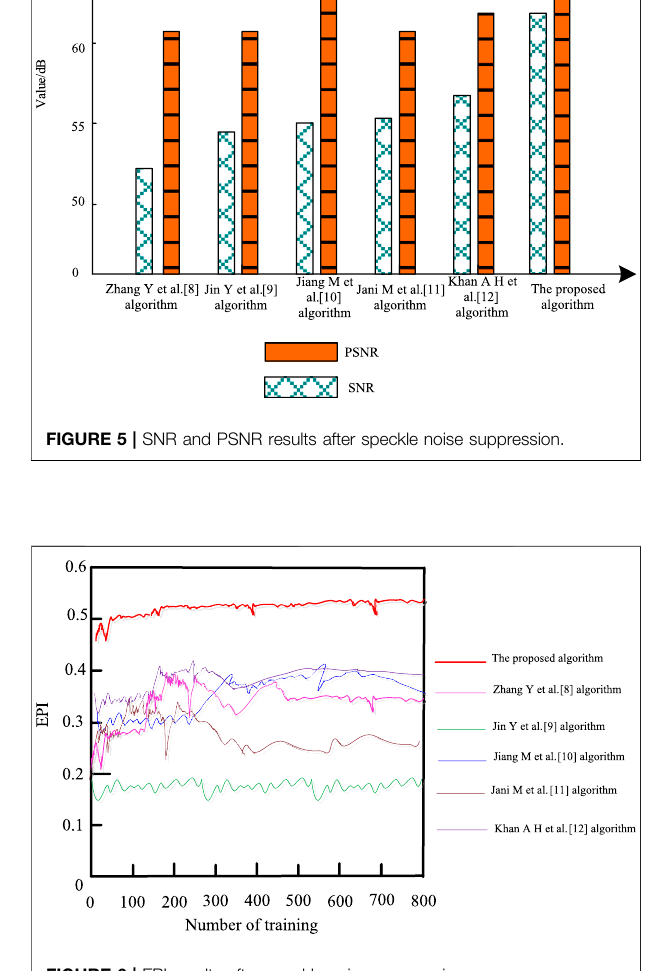
FIGURE 6 | EPI results after speckle noise